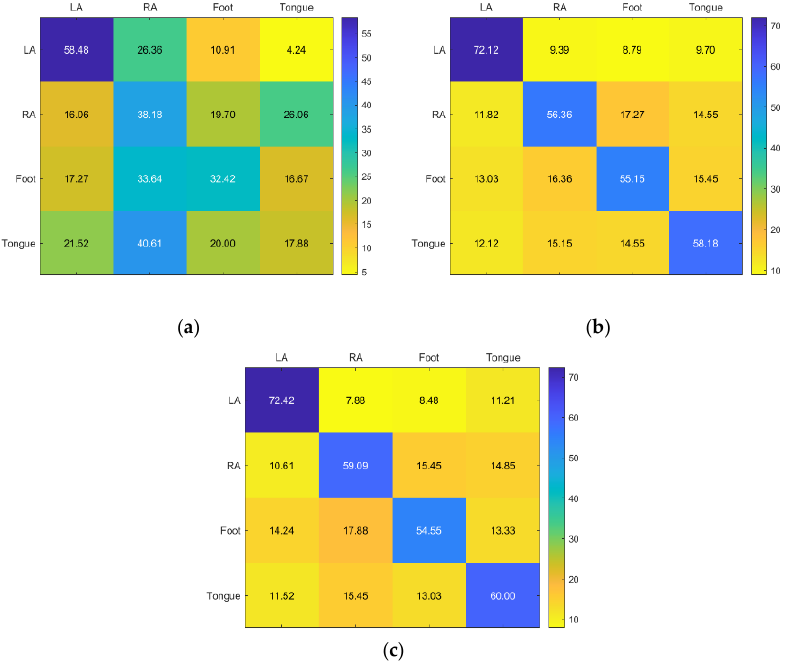
Figure 15. Confusion matrices for the ( a ) KNN, ( b ) SVM, and ( c ) RF classifiers to demonstrate the MI-BCI performance from the ninth subject’s four classes (left hand, right hand, feet, and tongue).